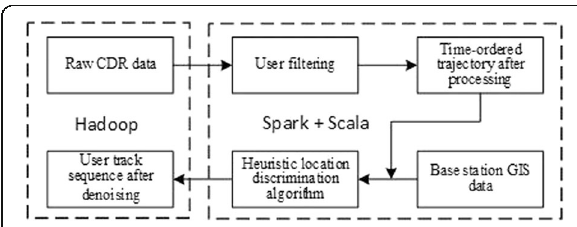
Fig. 1 Data processing flow